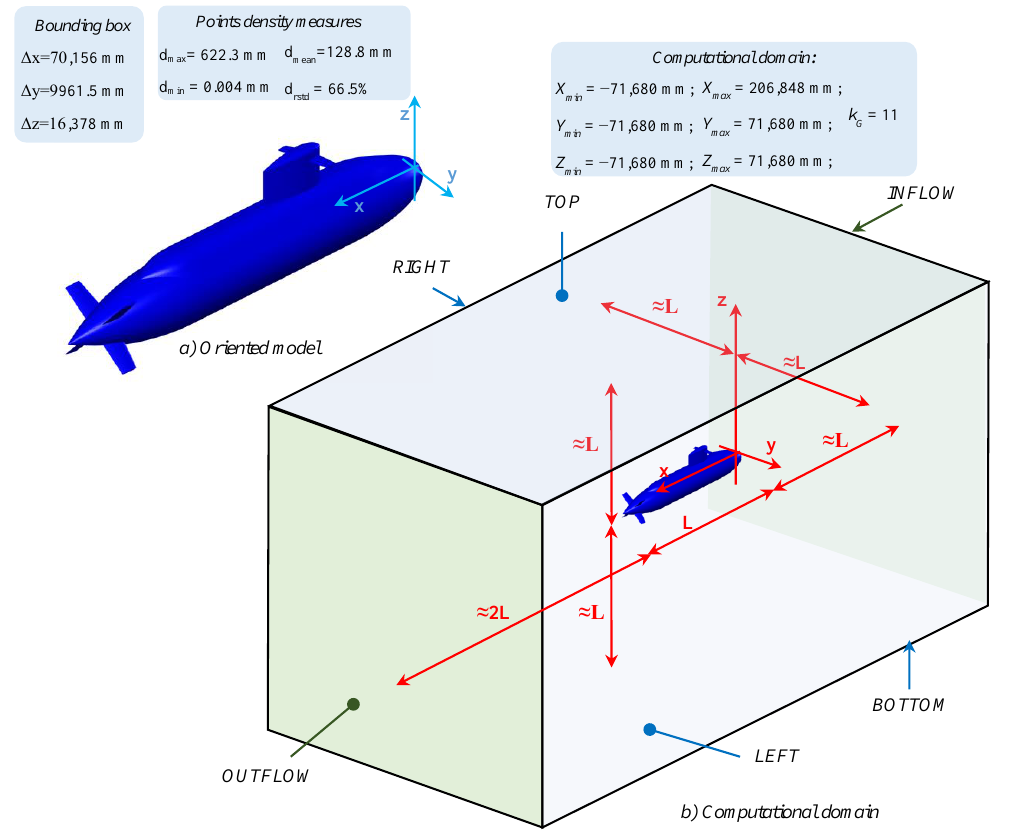
Figure 5. The oriented model ( a ) and the computational domain ( b ).